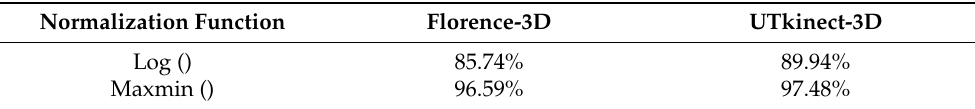
Table 4. Compare the recognition results of two normalization function on two datasets using our network.